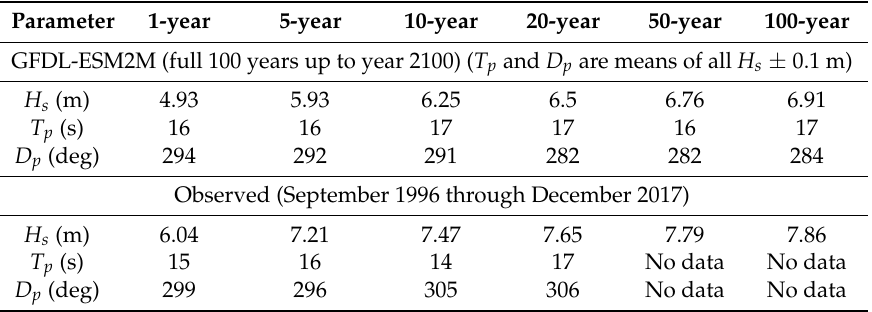
Figure 3. Deep-water conditions at CDIP067 in relation to nearshore transect locations. Dashed line shows the extent of the regional CoSMoS model grid (see Section 2.2.3.3). Table 1. Projected and observed deep-water waves at buoy CDIP067. A Generalized Pareto Distribution (GPD) was fit through the wave data and in the case of the observation data, extrapolated for return periods greater than the length of the time-series. Listed T p and D p are the means of all instances for which the shown H s ± 0.1 m occurred.